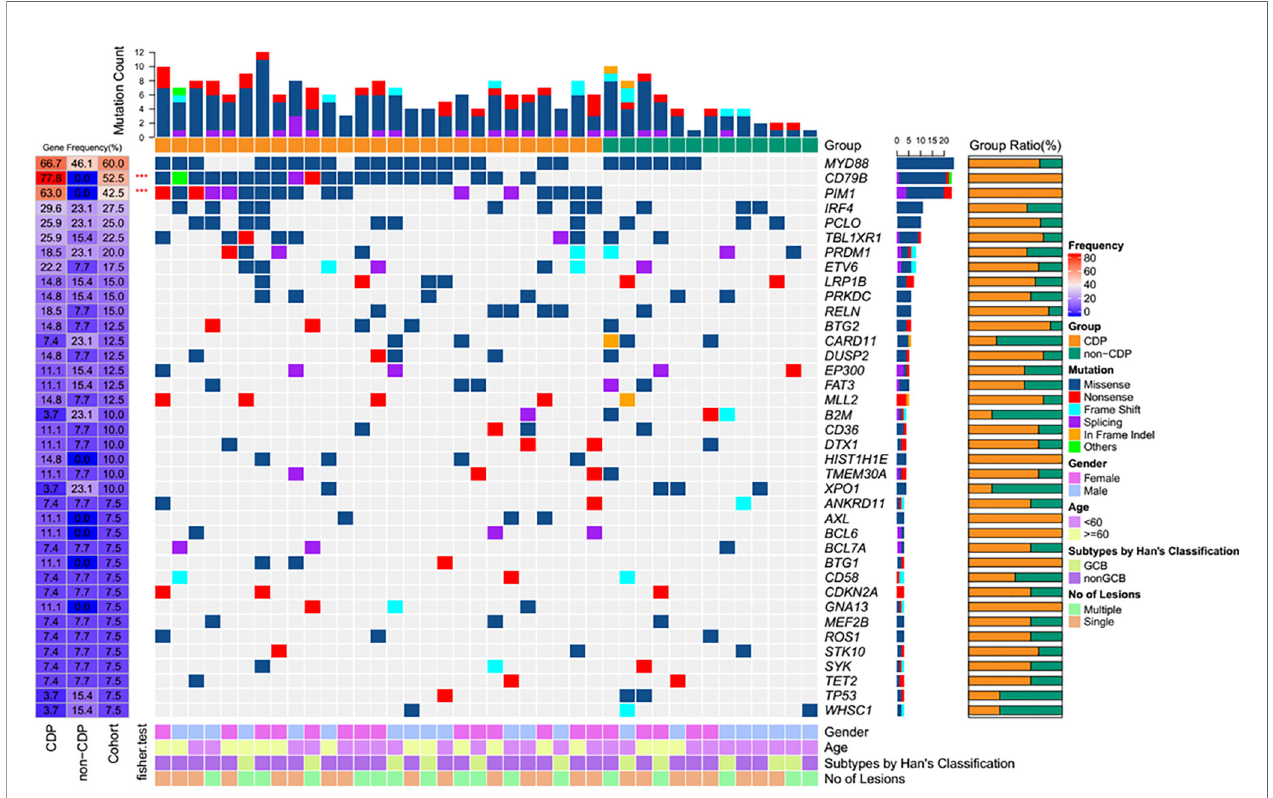
FIGURE 2 | Heatmap of frequently mutated genes and clinical characteristics of the CDP and non-CDP